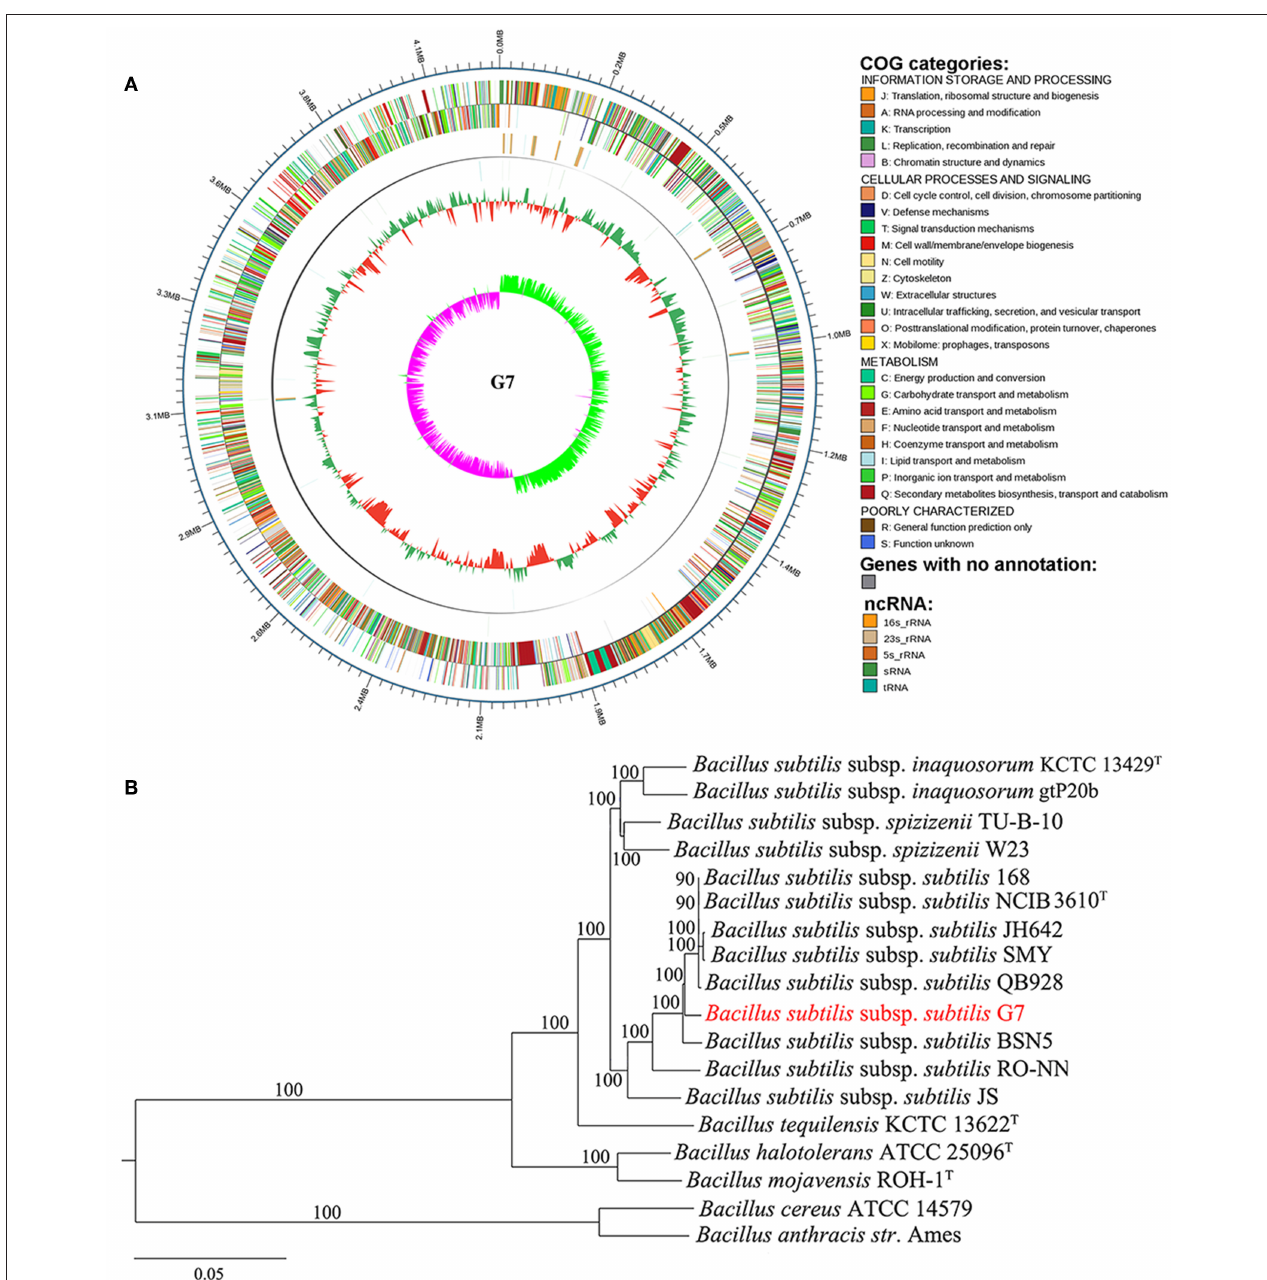
FIGURE 2 | Circle genome map (A) and core genome phylogeny (B) of G7. (A) The scale on the outside of the circles indicates the size of G7 genome; the chromosome is represented by circles ranging from 1 (outer) to 4 (inner). Circle 1, the genes annotated by COG database (indicated by colors other than gray) and genes with no annotation (indicated by gray color); Circle 2, ncRNA, with colors indicating different types of ncRNA as shown in the figure; Circle 3, GC content; Circle 4, GC skew. (B) Neighbor-joining tree was constructed based on 1,113 highly conserved orthologous genes of 18 annotated genomes of Bacillus . Each node number represents the percentage of bootstrap support from 1,000 resampled datasets. The scale bar represents 0.05 substitutions per site.